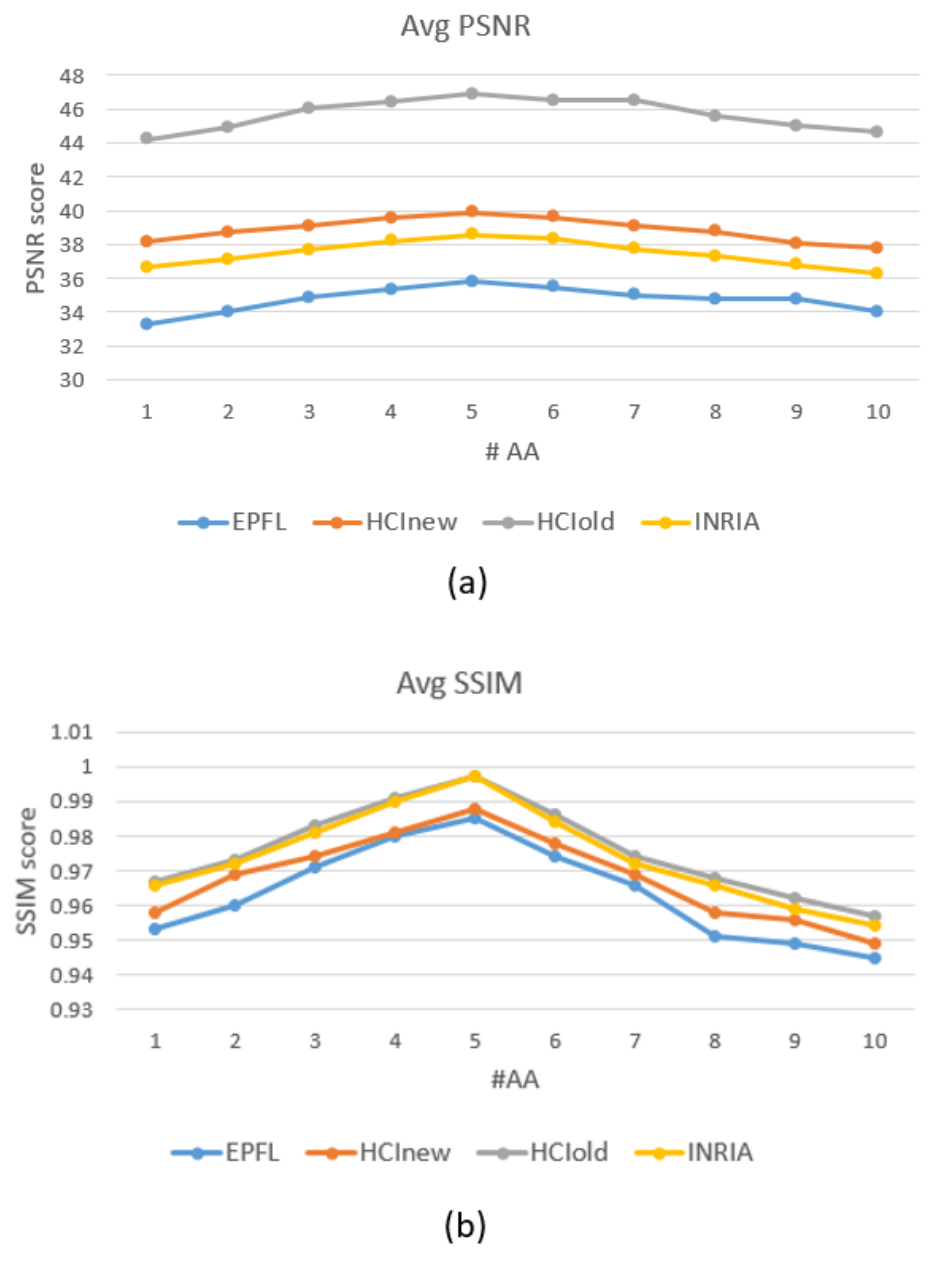
Figure 2. Relation between the number of alignments and average image quality scores using PSNR and SSIM, which were applied to the datasets INRIA [80], HCInew [81], EPFL [82], and HCIold [83]. ( a ) PSNR, and ( b )